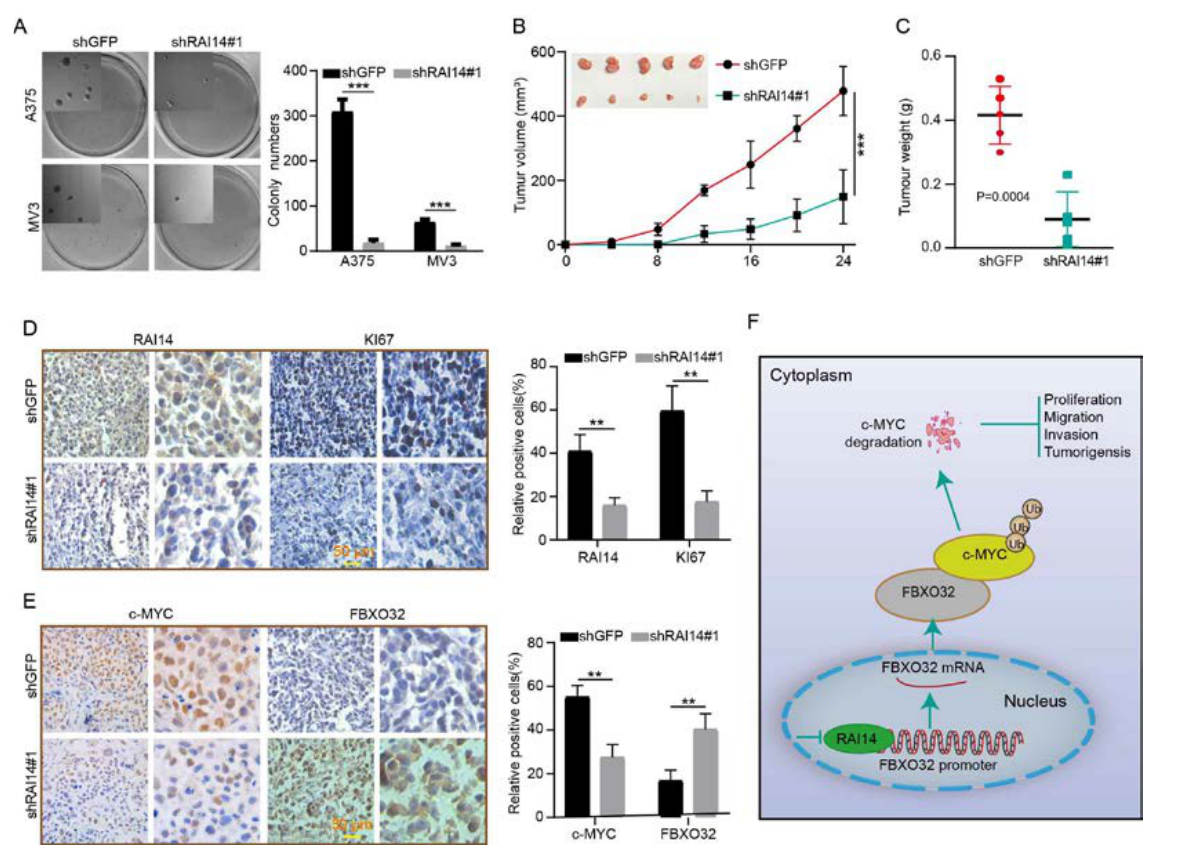
Figure 6. RAI14 knockdown inhibits tumor growth and improved prognosis in mice. ( A ) The effect of knockdown RAI14 on the colony-forming ability of melanoma cells was detected by soft agar assay. ( B , C ) Volume and weight of xenograft tumors were counted and analyzed. ( D , E ) The expressions of RAI14, Ki67, c-MYC and FBXO32 were detected by immunohistochemical staining. ( F ) A model of the regulatory mechanism of RAI14 in melanoma. The data were expressed as mean ± SD. Student’s t-test was performed to analyze significance. ** p < 0.01, *** p < 0.001.